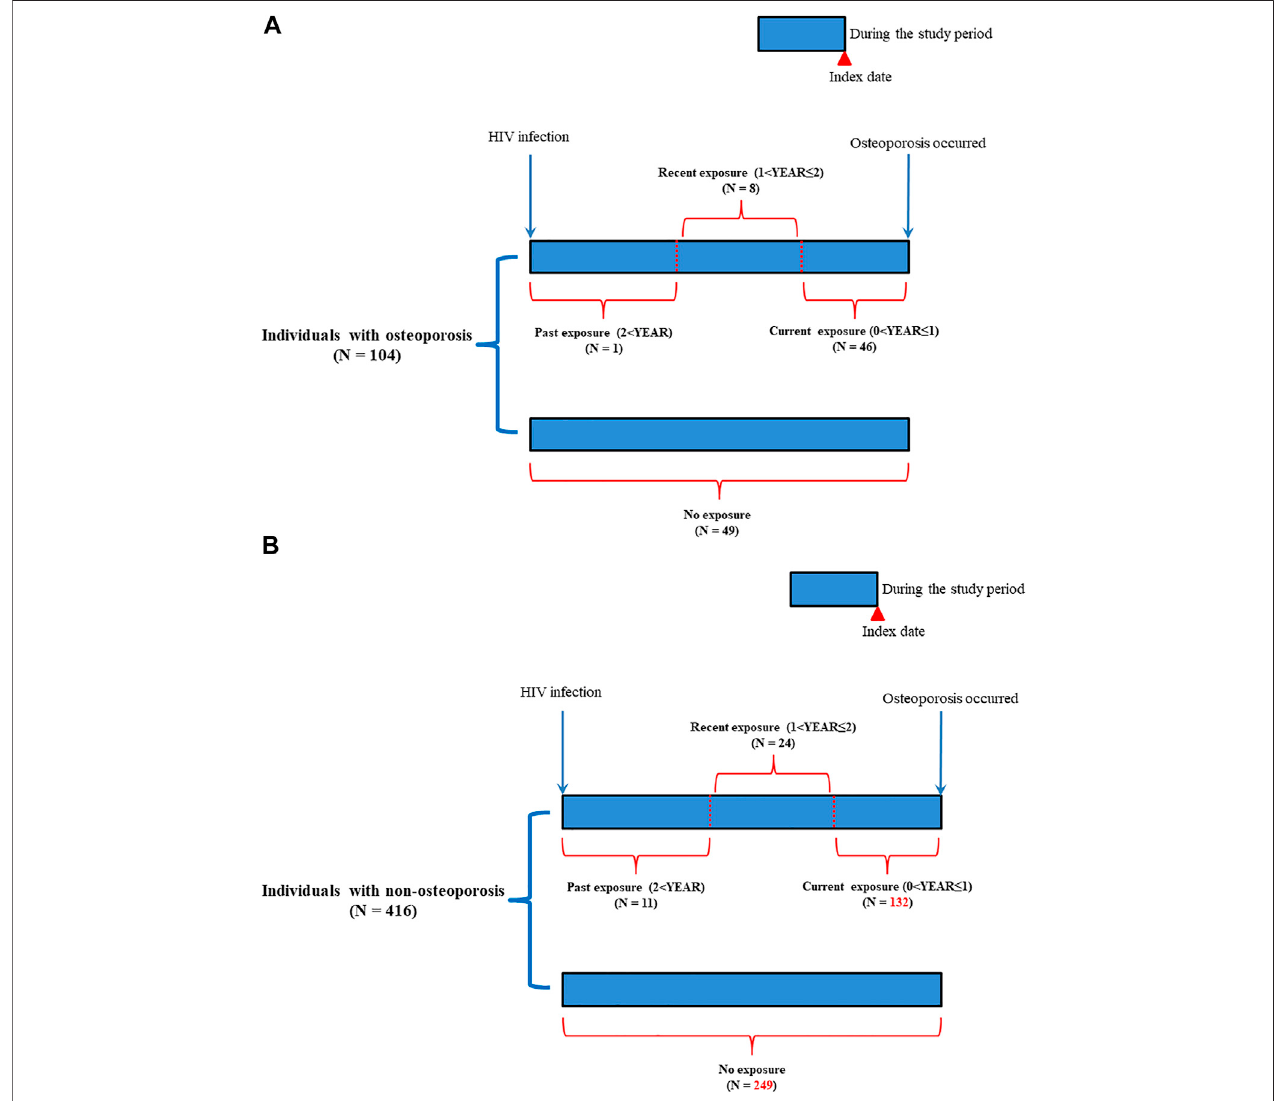
FIGURE 3 | Follow-up time for patients with HIV infection. (A) : Patients with osteoporosis; (B) : Patients with non-osteoporosis.